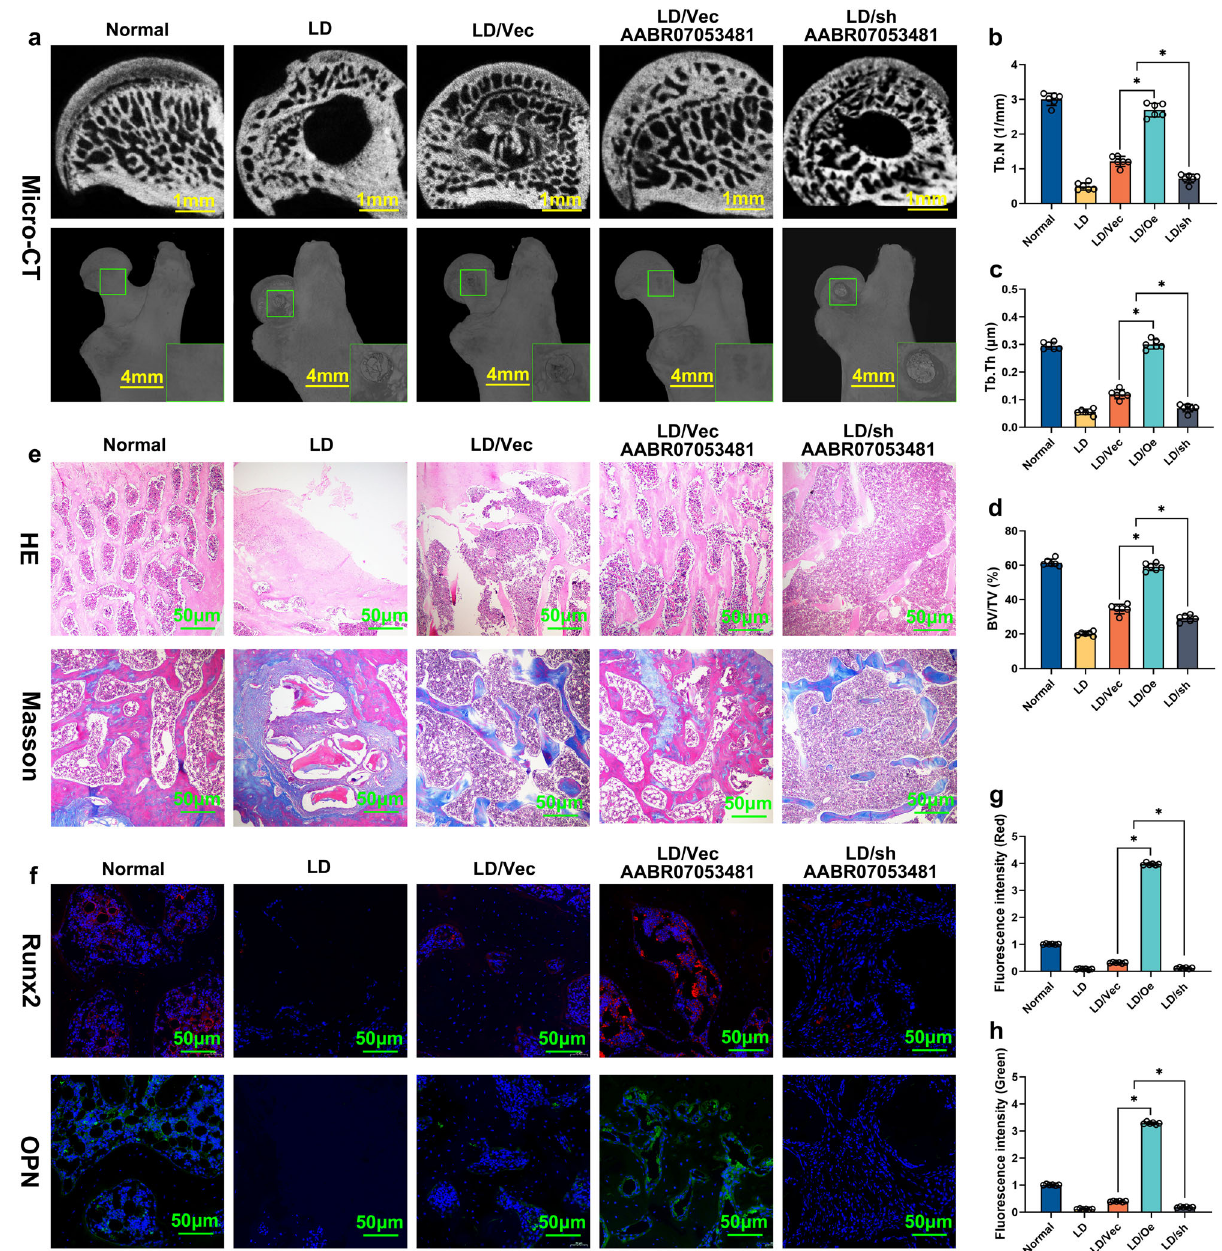
Fig. 6 LncAABR07053481-overexpressed BMSCs promote the repair of early SANFH. a At 12 weeks after BMSC transplantation, micro-CT was used to analyze the repair of the necrotic area of the femoral head ( n = 6). b – d Quantitative analysis of the number of trabeculae, the trabecular thickness, and the volume fraction of new bone tissue ( n = 6). e At 12 weeks after BMSC transplantation, H&E and Masson staining were used to evaluate the repair of the necrotic area of the femoral head ( n = 6). f At 12 weeks after BMSC transplantation, immunohistochemistry was used to detect osteogenic markers of runt-related transcription factor 2 (Runx2, Cy3 label, red) and osteopontin (OPN, FITC label, green) ( n = 6). g Quantitative analysis of Runx2 expression ( n = 6). h Quantitative analysis of OPN expression ( n = 6). Data were shown as mean ± SD. * P < 0.05; In ( b – d , g , h ), statistical signi fi cance was calculated by one-way ANOVA with Tukey ’ s post hoc